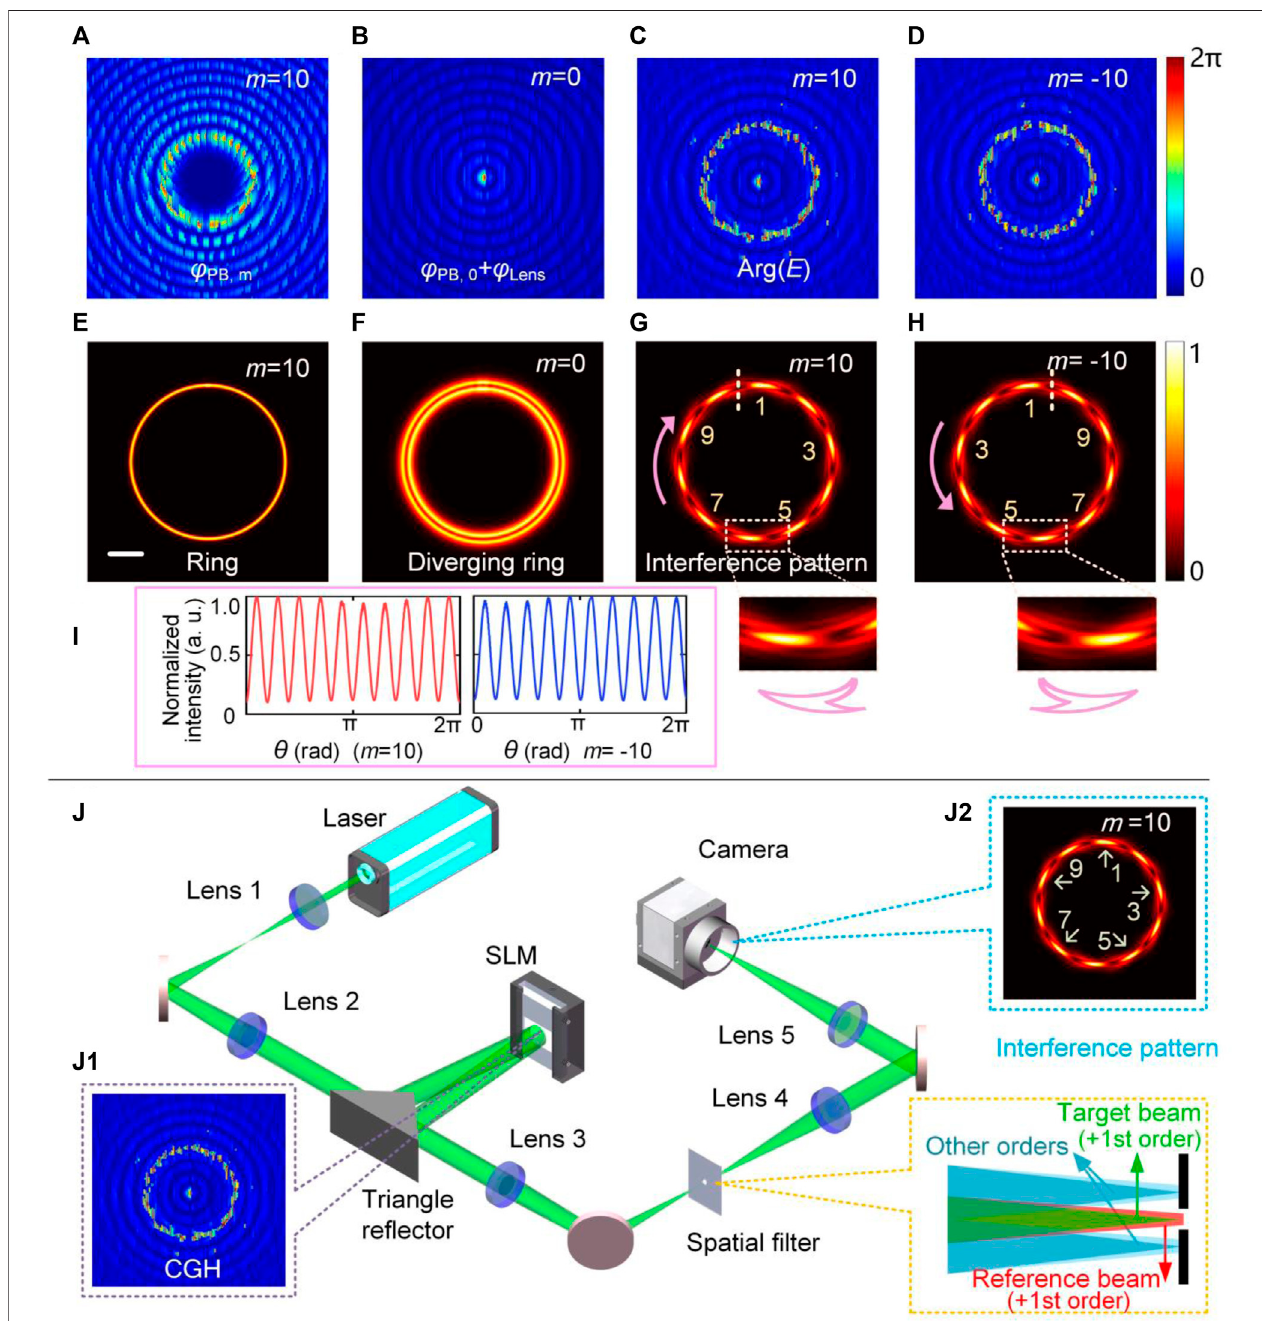
FIGURE 1 | Simulation results of determination of PGP of ring-shaped beams by the SDI method. (A) phase hologram for generation of a ring-shaped beam with m = 10. (B) phase hologram for generating a defocused ring-shaped beam with m = 0 through a Fresnel lens phase. (C,D) phase holograms for generating the interference patterns with m = ±10. (E – H) correspond to the simulated focal plane patterns generated in (A – D) . The insets in (G,H) show the detail of the interference fringes. (I) The azimuthal intensity pro fi les of the interference patterns in (G,H) . Scale bar: 100 μ m. (J) The schematic of the experimental setup. (J1) The complex amplitude coded hologram. (J2) The interference pattern with m =